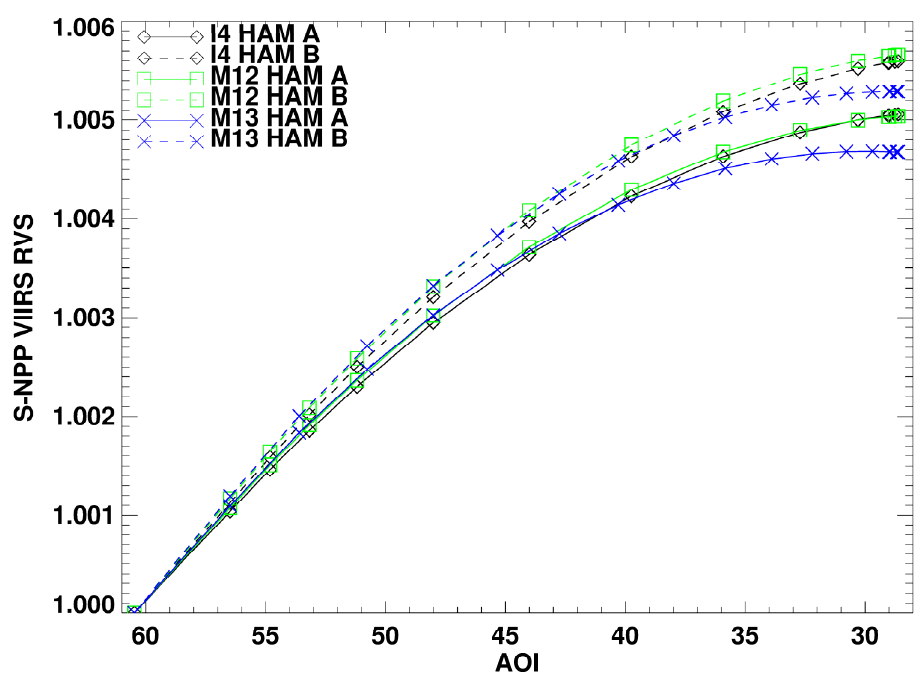
Figure 18. Band-averaged RVS for S-NPP VIIRS all TEBs from the SV AOI through to the end of scan AOI for the MWIR bands.